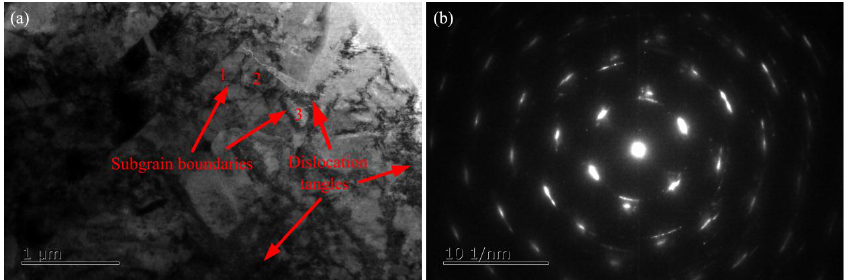
Figure 15. ( a ) TEM image showing subgrains of the bottom area after laser flexible shock; ( b ) the electron diffraction of the corresponding selected area.